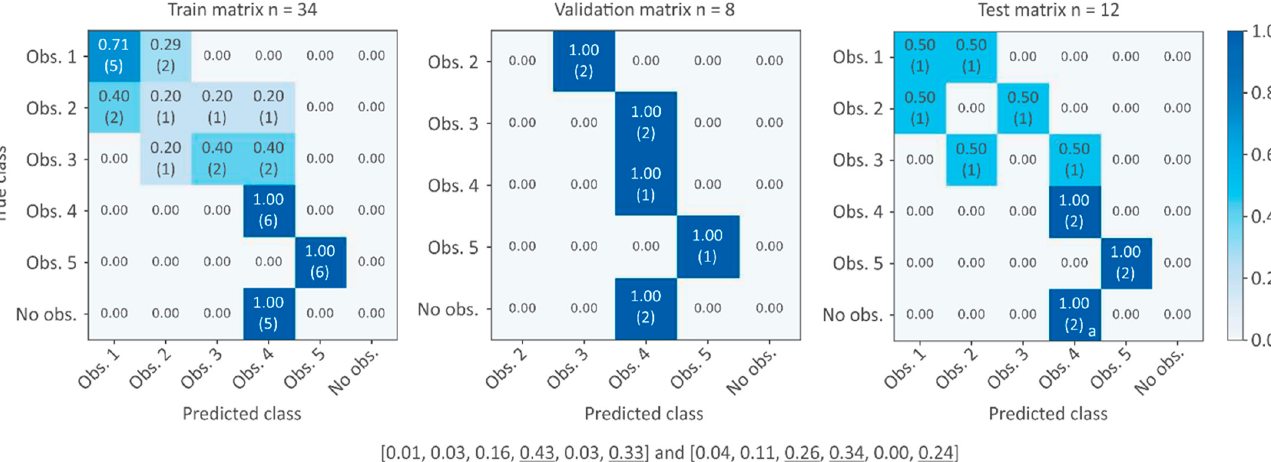
Figure 8. Confusion matrix for training, validation, and test datasets using two nodes. Misclassifications of no obstruction class in test dataset (class probabilities of misclassifications are indicated at the bottom of the picture).